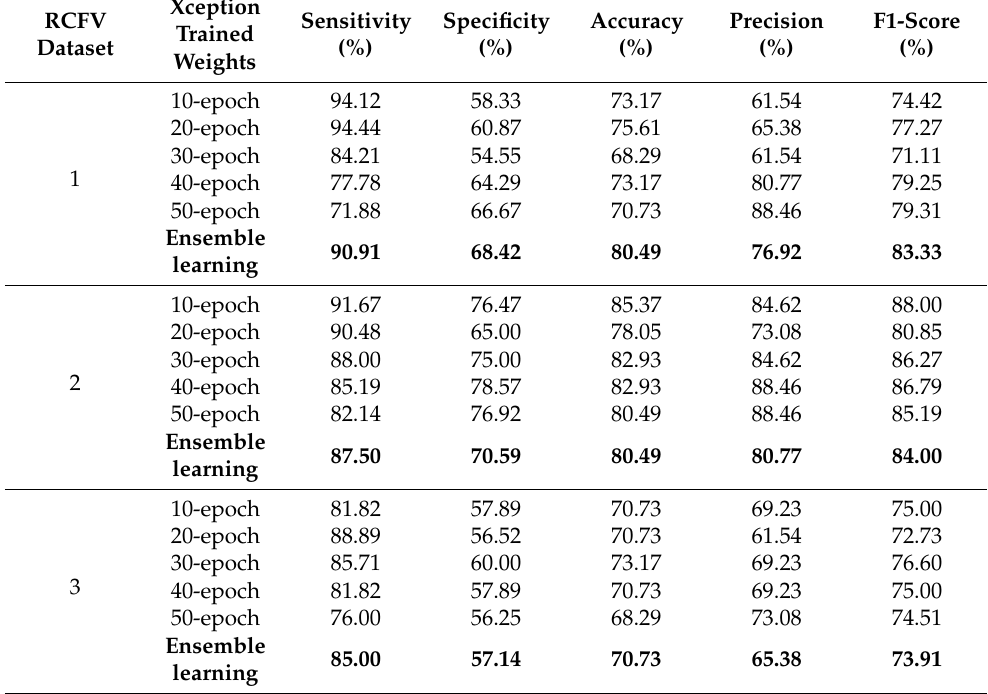
Table 10. The Xception performance of specified weights with ensemble learning.